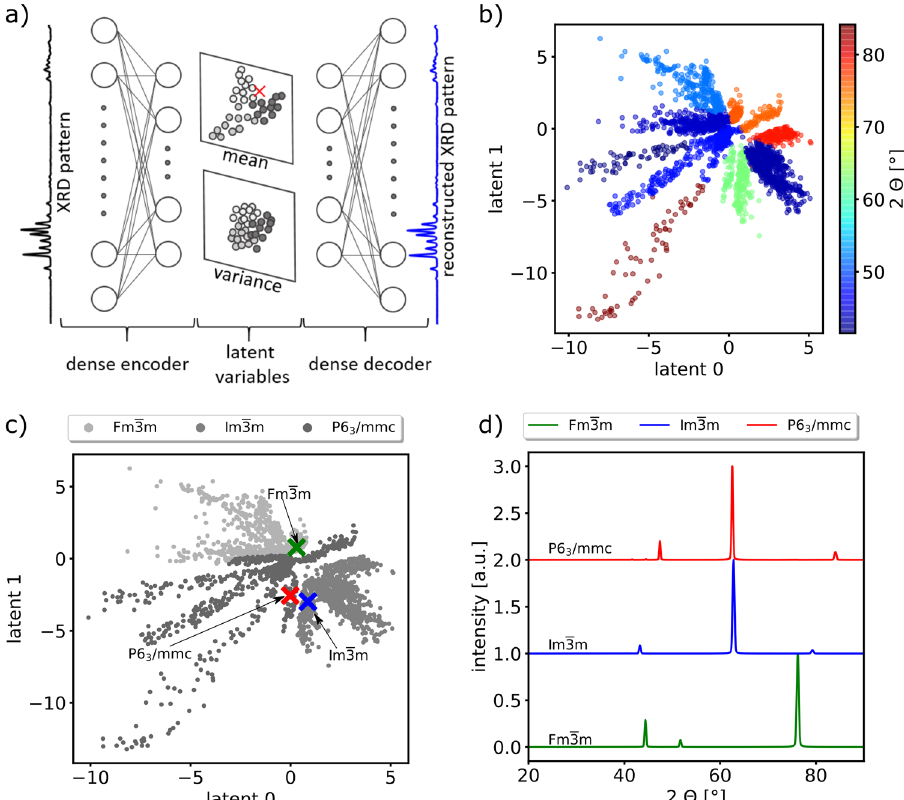
Fig. 1 Visualization of the VAE latent space representation. a Schematic VAE architecture. XRD patterns are encoded into a low dimensional representation (mean, variance). The red cross marker indicates the latent space position of the encoded XRD pattern with respect to the prior (circles). The latent vector is decoded into a reconstructed XRD pattern. b Latent space embedding with color-coded diffraction angle 2 Θ of maximum XRD intensity. c Latent space embedding of an exemplary synthetic dataset. Im 3 m is clearly separated from Fm 3 m and P6 3 /mmc. The x-markers show the latent space position of the corresponding XRD patterns in ( d ). d XRD patterns of the x-marked latent space positions in ( c ). The latent space embedding in b) clearly shows the main re fl ection axes of the different crystal structures, i.e. P6 3 /mmc has six main re fl ection axes in the angular range from 20 to 90°2 Θ (for Cu K α ). It further elucidates possible ambiguities between different structures that exhibit a preferred orientation: Fm 3 m (111) and P6 3 /mmc (002) as well as Im 3 m (020) and P6 3 /mmc (102) have peaks at a similar diffraction angle. This is important during the pattern matching task, as an experimental XRD pattern could be a result of either